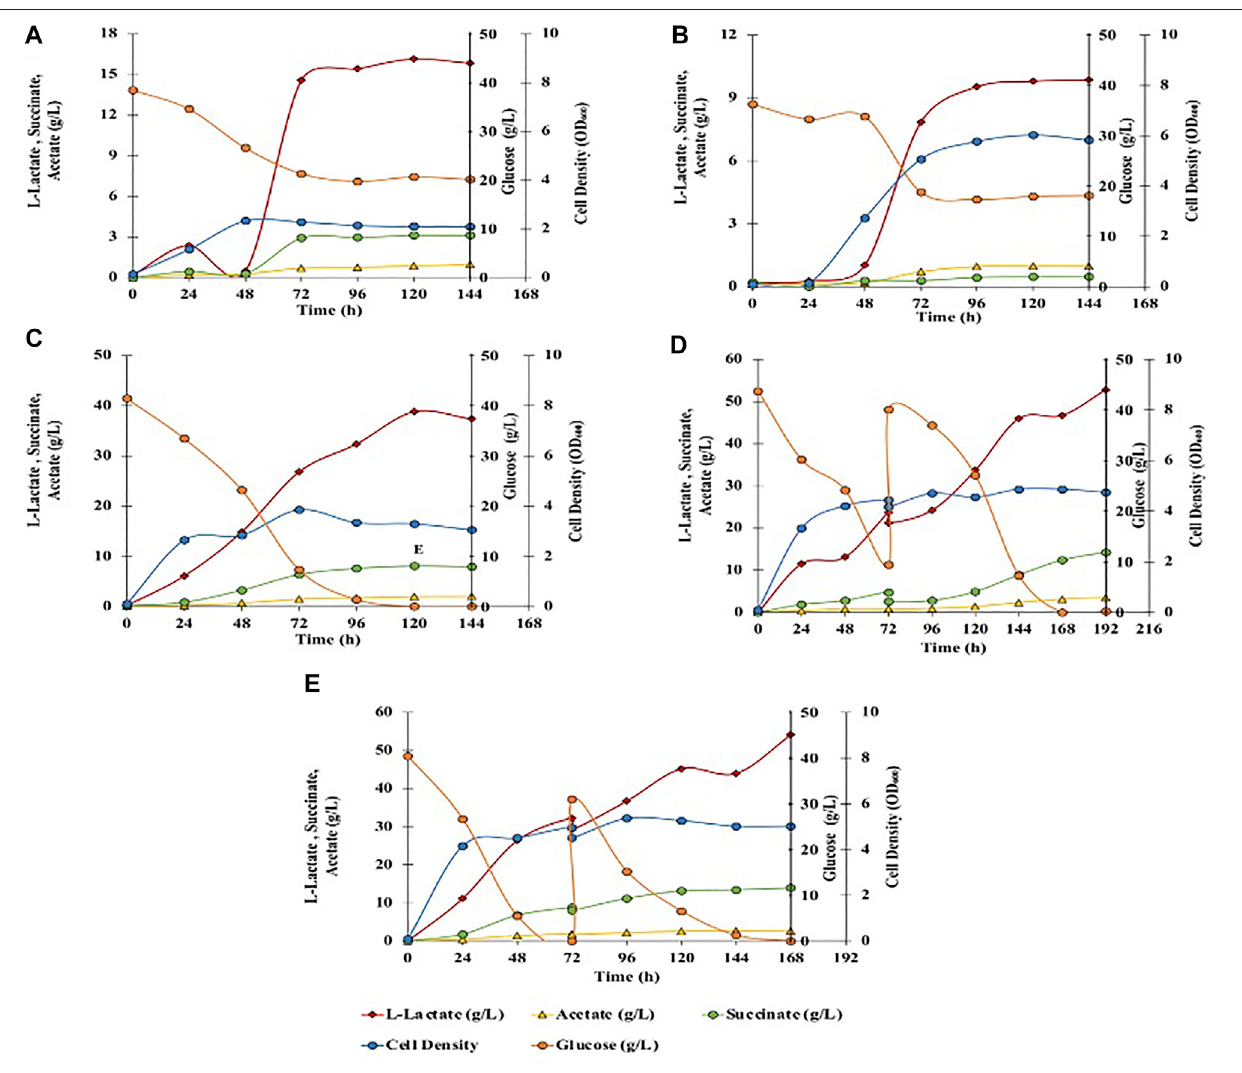
FIGURE3| Effectofdifferentfermentationcultivationparametersonmixed-acidsproductionby C.glutamicum. Dataisshownforsinglefedbatchfermentation. (A) Anaerobic, batch, no pH control, BTM2 supplemented with glucose; (B) Aerobic, batch, no pH control, BTM2 supplemented with glucose; (C) Anaerobic, batch, pH 7, BTM2supplementedwithglucose; (D) Anaerobic,fed-batch:40 g/L(0 h)+30 g/L(72 h),pH7,BTM2; (E) Anaerobicwithinitialaerationfor16 h,fed-batch:40 g/L(0 h) + 30 g/L (72 h), pH 7, BTM2.